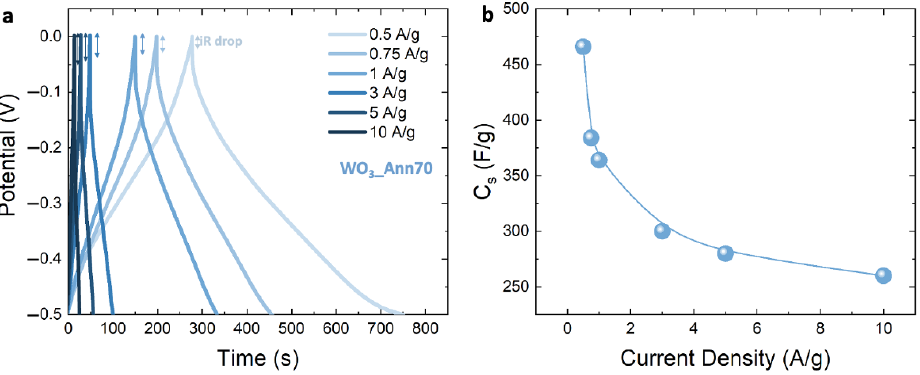
Figure 5. ( a ) GCD curves of NF WO 3 _Ann70 paste-based electrode obtained in 1 M H 2 SO 4 solution at different current densities. The iR drop is indicated for each GCD curve; ( b ) C s as a function of current density obtained from the GCD curves; potential measured versus SCE.